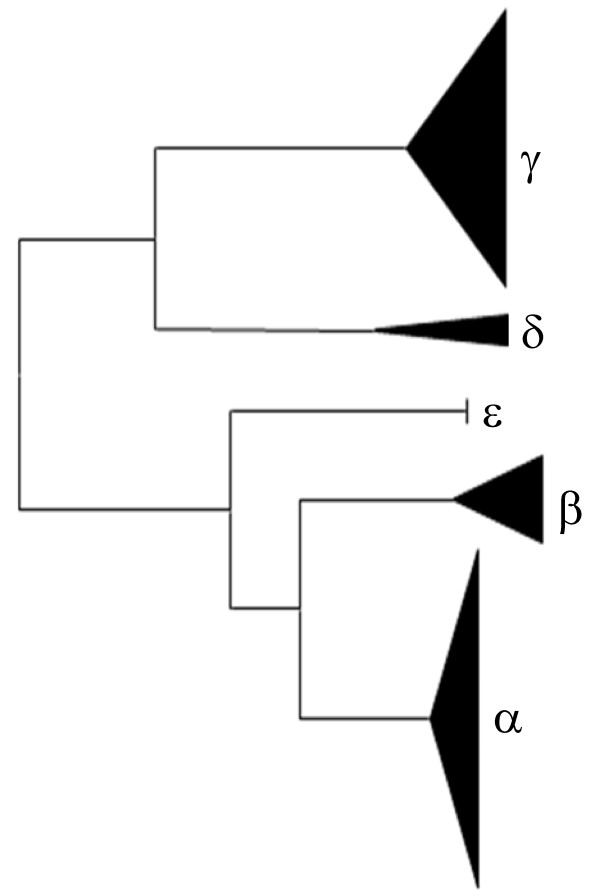
Phylogenetic tree of intron sequences. Intron sequences were aligned manually (Additional file 2). Maximum likelihood and maximum parsimony methods both produced the unrooted tree shown. The five major clades were used to define the five intron types, as shown.